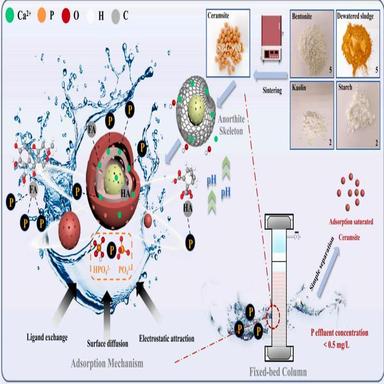
Schematic illustration of the adsorption mechanism and column studies.